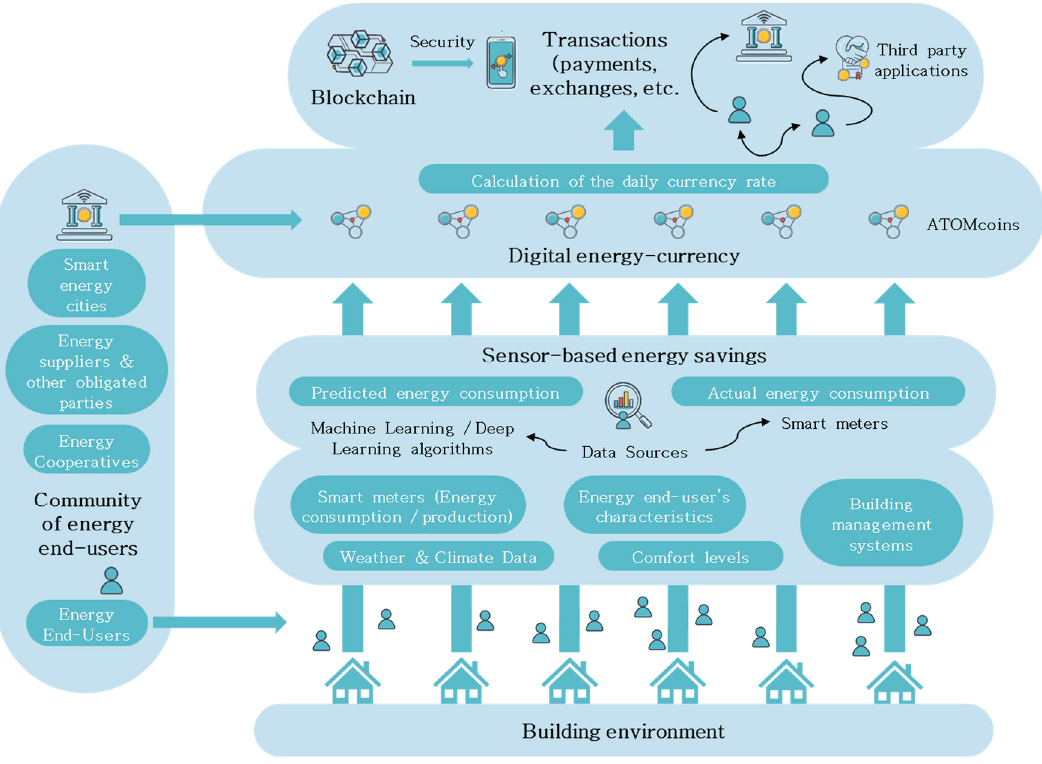
Figure 1. Components of the proposed framework.